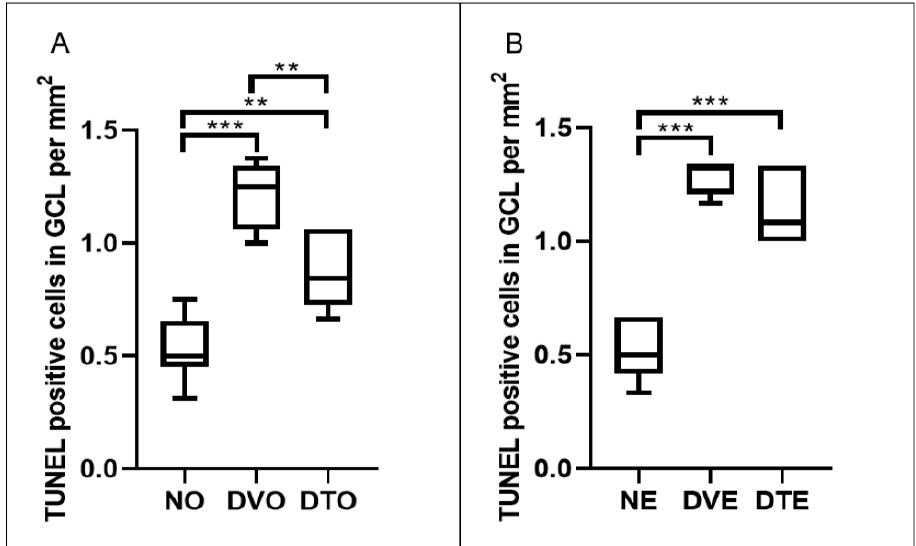
Figure 8. E ff ect of TRF on the retinal cell apoptosis is presented as TUNEL-positive cells per mm 2 area of a ganglion cell layer in rats with STZ-induced diabetes. Data is presented using box and whisker plots. Boxes show median, lower quartile, and upper quartile, whereas whiskers show the data variability outside the upper and lower quartiles. Rats were treated by ( A ) oral and ( B ) topical routes over 12 weeks of the experimental period. NO: Normal rats with oral vehicle treatment, DVO: Diabetic rats with oral vehicle treatment, DTO: Diabetic rats with oral TRF treatment. NE: Normal rats with topical vehicle treatment, DVE: Diabetic rats with topical vehicle treatment, DTE: Diabetic rats with topical TRF treatment, n = 6; ** p < 0.01; *** p < 0.001. Biomolecules 2020 , 10 , 556